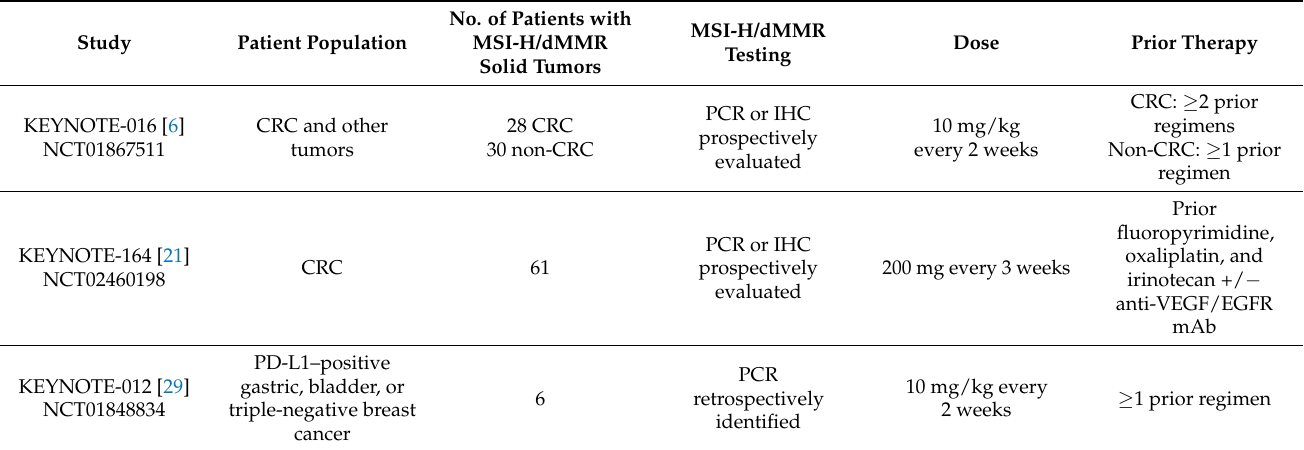
Table 2. Clinical trials for MSI-H/dMMR solid tumors upon which the FDA based approval for